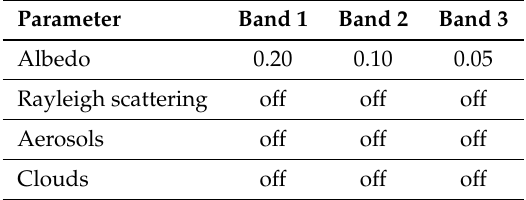
Table A3. Scattering parameters of scenarios Baseline , SIF , and XCO 2 + 6 ppm .